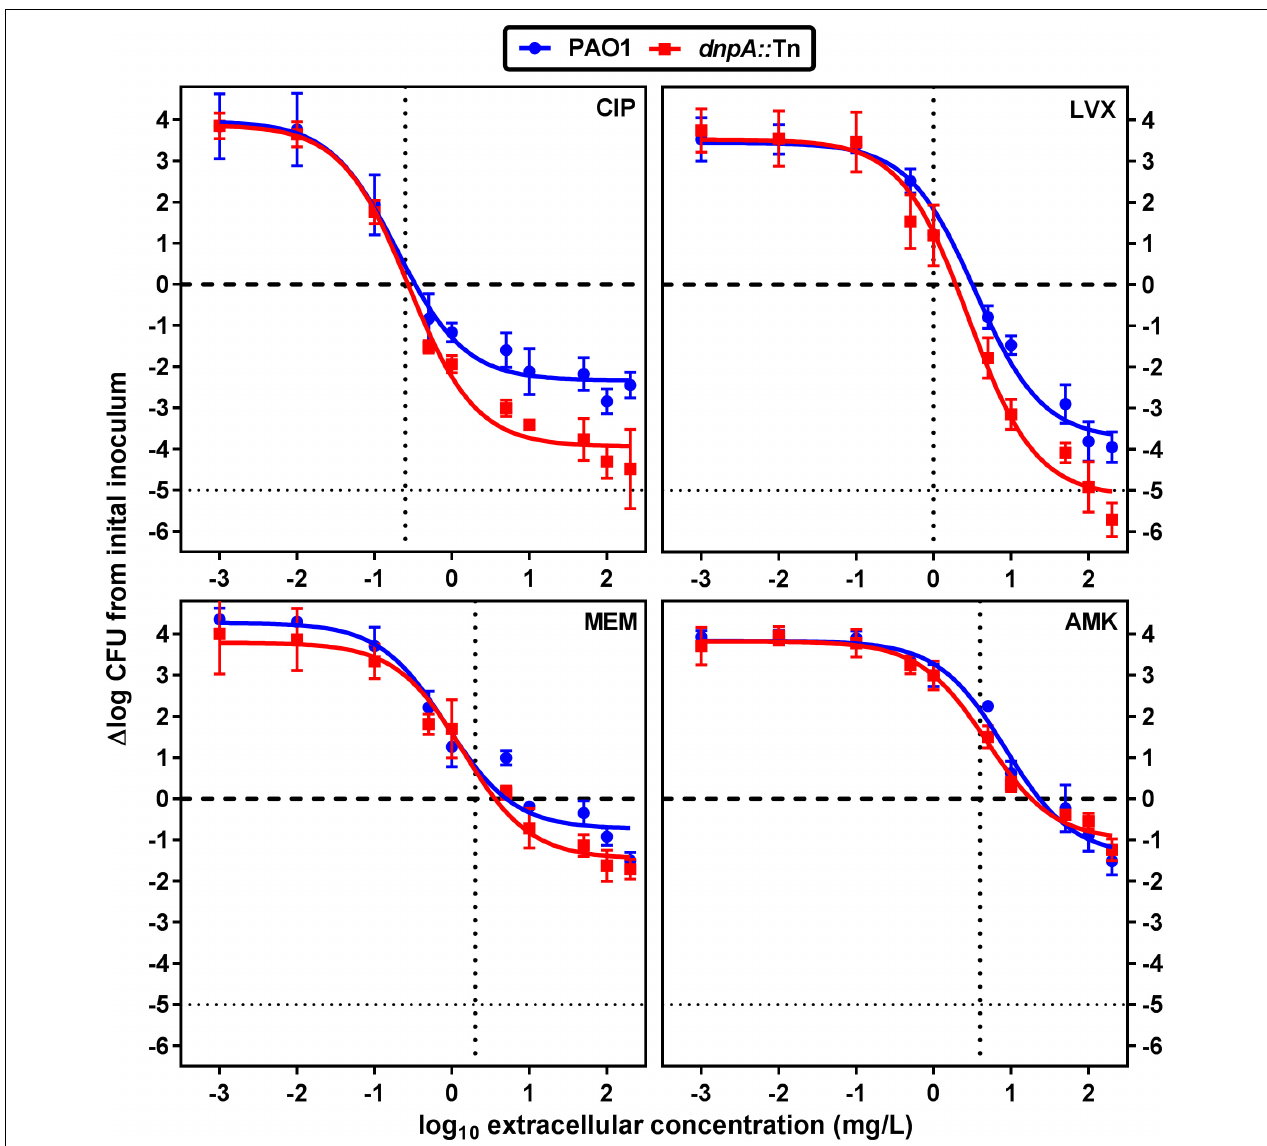
FIGURE 2 | Concentration-response curves of antibiotics against intracellular P. aeruginosa . The graphs show the changes in the number of cfu/mg of cell protein in THP-1 cells after 24 h of incubation with increasing extracellular antibiotic concentrations. Values are the mean ± SEM of at least 3 experiments performed in triplicates. Vertical dotted lines indicate MIC value in broth. The tick horizontal dotted line indicates a bacteriostatic effect and the thin horizontal dotted line, the limit of detection. CIP, ciprofloxacin; LVX, levofloxacin, MEM, meropenem, AMK, amikacin. See Table 3 for pharmacodynamic parameters and statistical